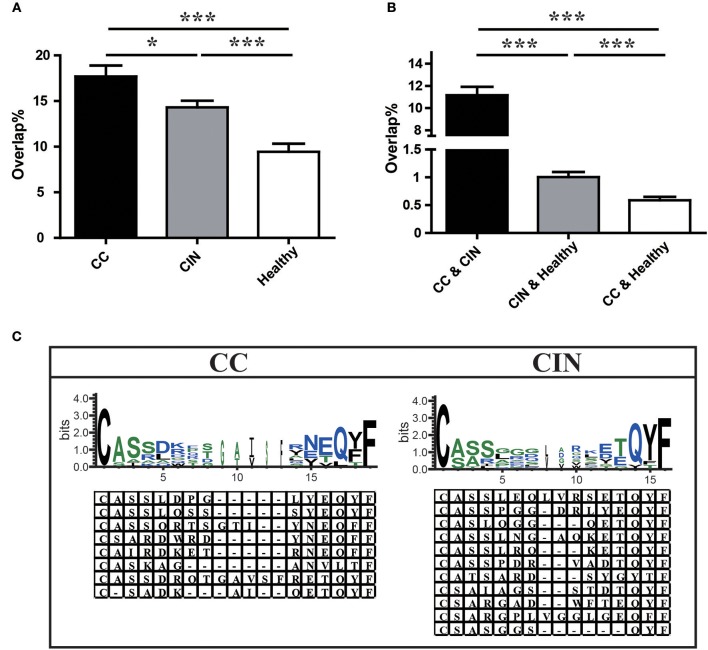
Comparison of clonotypes in peripheral blood TCR repertoire within each group and between different groups. (A) The overlap of clonotypes within each group, CC, CIN, and Health. (B) The overlap of clonotypes between every two groups, CC and CIN, CC and Health, and CIN and Health. *P < 0.05, ***P < 0.001, one-way ANOVA test. (C) The amino acid characteristics of disease-associated clonotypes in the CC (left) and CIN (right) patients, which were identified based on similarities in their CDR3 aa sequences using the CD-HIT program (90% quantile). Hydrophilic amino acids (RKDENQ) are shown in blue, neutral amino acids (SGHTAP) are shown in green, hydrophobic amino acids (YVMCLFIW) are shown in black.